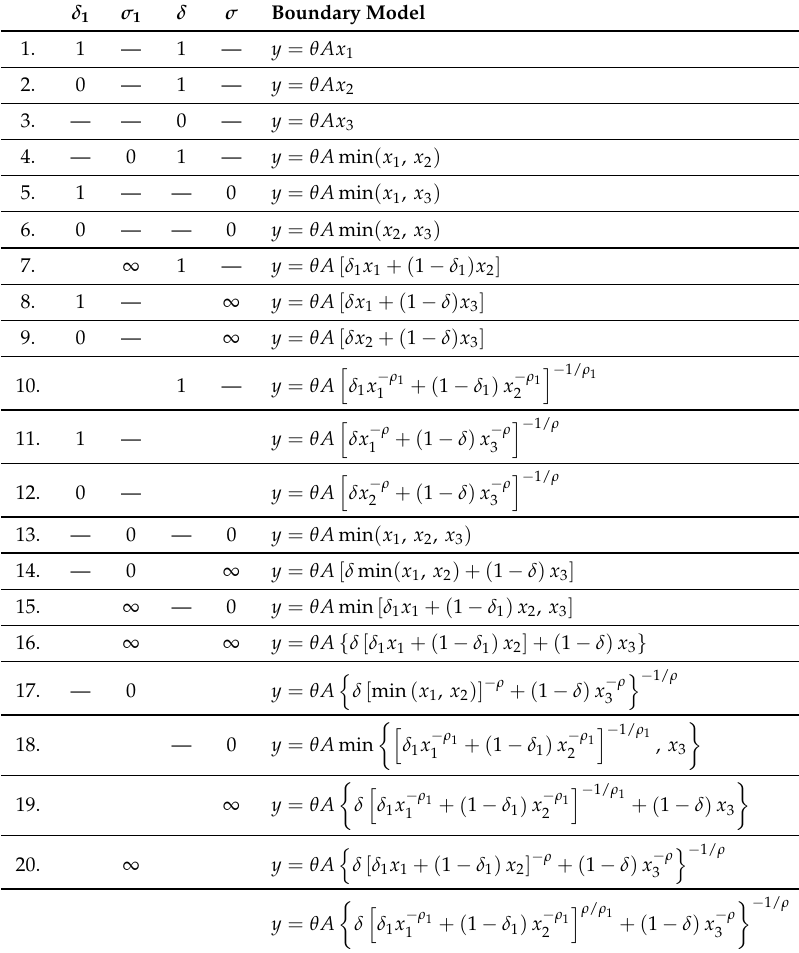
Table 2. Constant Elasticity of Substitution (CES) boundary models (rows 1–20) and the generic three-factor CES equation (bottom row). Factors of production ( x 1 , x 2 , x 3 ) are permutations of capital, labor, and energy ( k , l , e ). Recall that σ 1 (and σ ) in the third (and fifth) columns and ρ 1 (and ρ ) in equations are related by σ 1 = 1 (and σ = 1 ). The economically-meaningful ranges of model 1 + ρ 1 1 + ρ parameters are 0 ≤ δ , δ 1 ≤ 1 and 0 ≤ σ , σ 1 < ∞ . A blank space indicates a parameter that must be fitted in the boundary model of that row, because it appears in the model. “—” indicates a parameter that cannot be determined by fitting the boundary model of that row, because it does not appear in the boundary model. Note that there are three possible states (lower boundary, unspecified, upper boundary) for four constrained parameters ( δ 1 , σ 1 , δ , σ ), which gives 3 4 = 81 possible boundary models. But many boundary parameter combinations yield equivalent CES boundary models. For example, all boundary parameter combinations that include δ = 0 yield the same boundary model, y = θ Ax 3 . Thus, there are far fewer unique boundary models (20) than the total number of degenerate